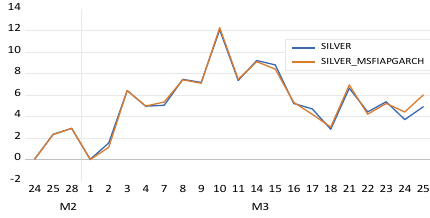
Figure 10. Silver, MS−FIAPGARCH.